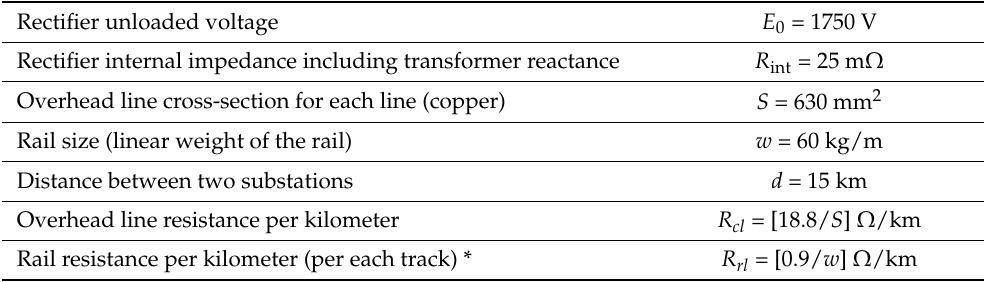
Table 4. Electrical parameters for a typical double-track line.